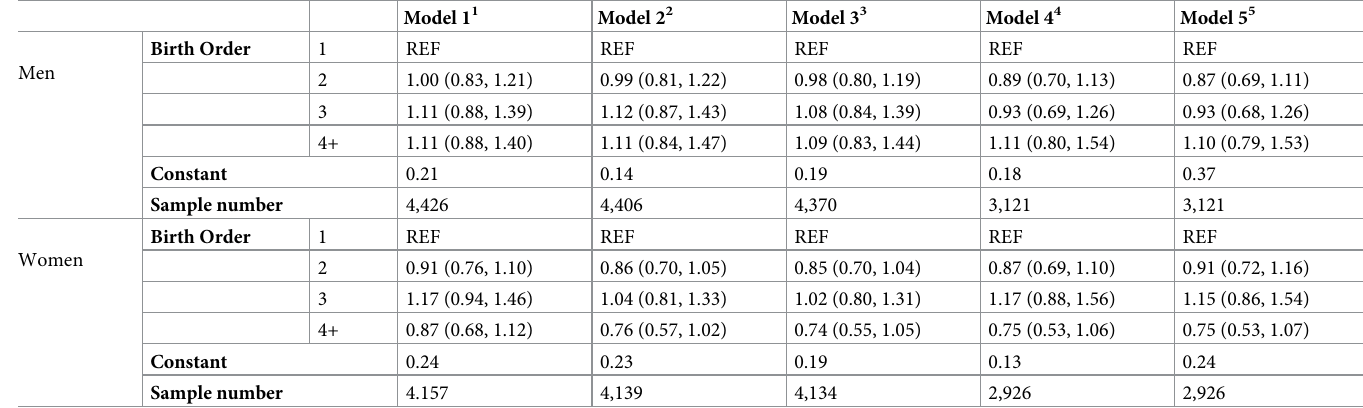
Table 4. Odds ratios from logistic regression models testing the association between birth order and the Malaise Index. Significant values are included in